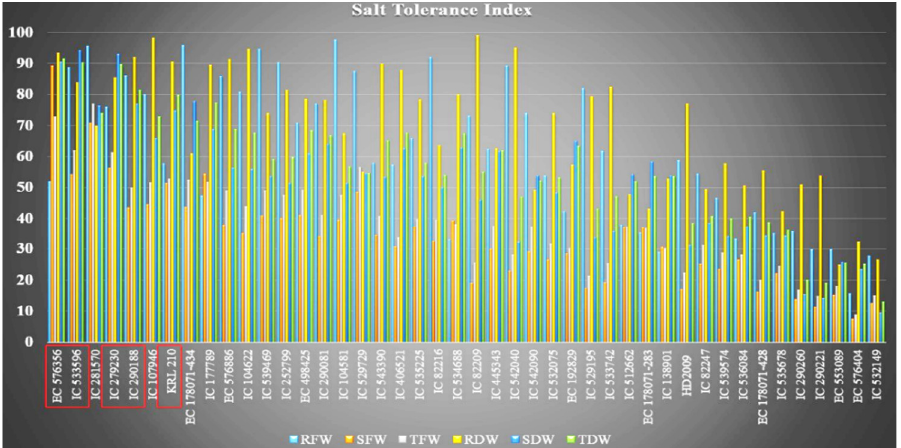
Figure 1. Bar plot of STI values of the 44 wheat accessions based on biomass traits (RFW: root fresh weight, SFW: shoot fresh weight, TFW: total fresh weight, RDW: root dry weight, SDW: shoot dry weight, and TDW: total dry weight) tested in 150 mM NaCl concentration. Tolerant genotype is indicated with a red